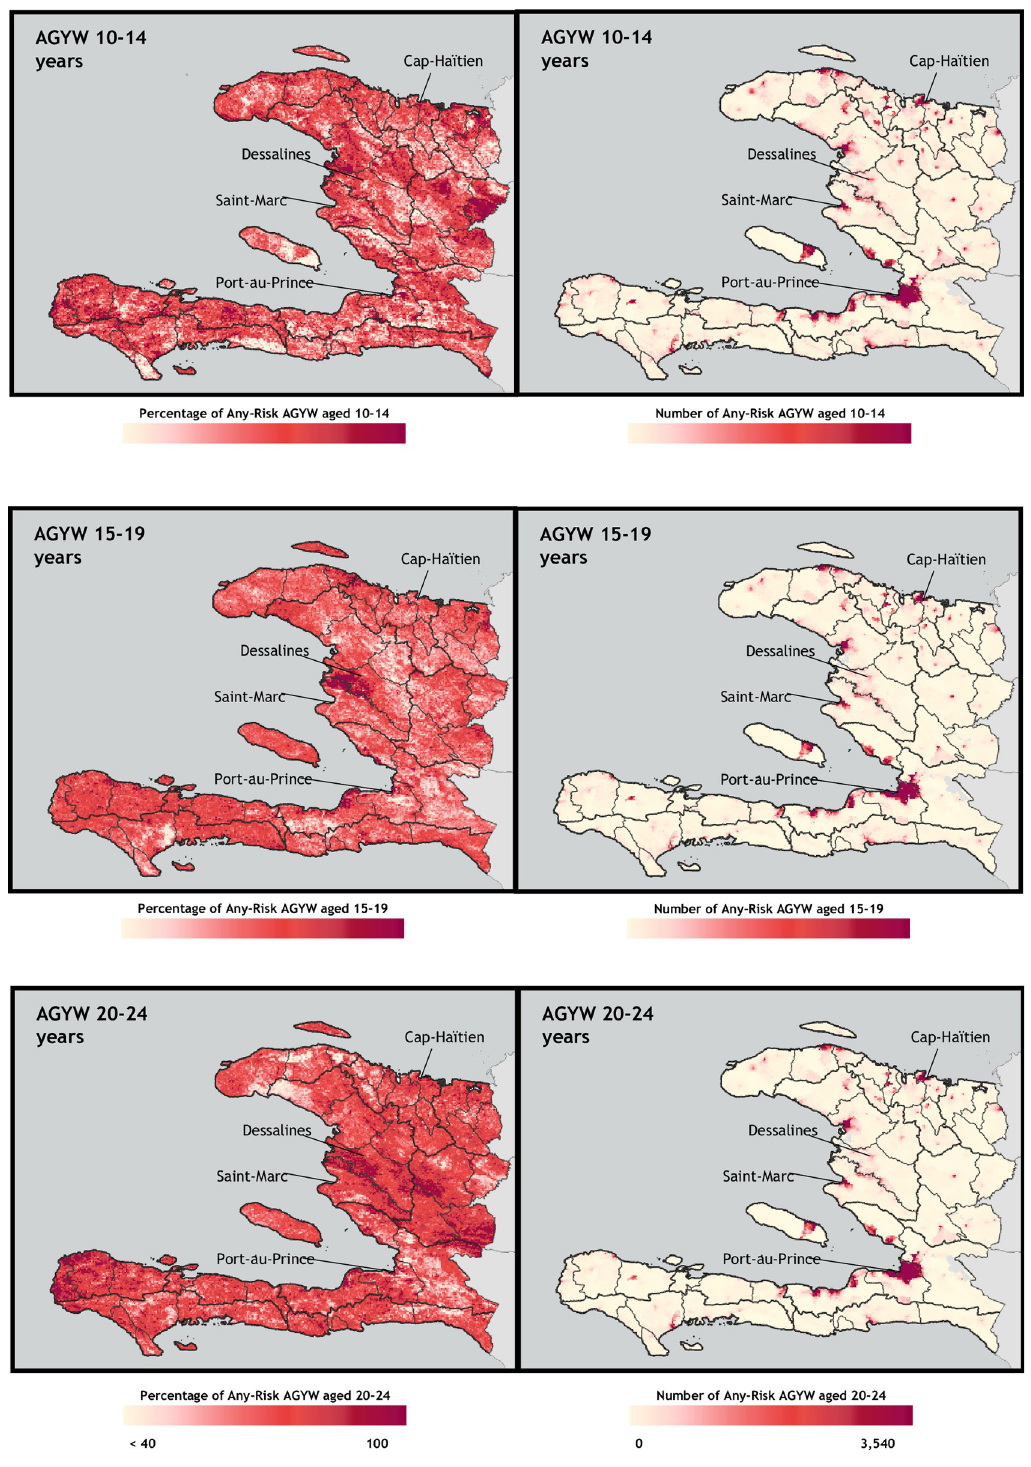
Fig 3. Hyperlocal heat maps of HIV risk prevalence (percentage at risk) and population density (number at risk), based on any-risk profile in Haiti, by age band. The number-at-risk is calculated as those AGYW who are both classified as at-risk and HIV-negative for AGYW ages 15+ and the number-at-risk for AGYW 10–14 years is calculated as those AGYW classified as at- risk. Base map and data from the Spatial Data Repository, The Demographic and Health Surveys Program.